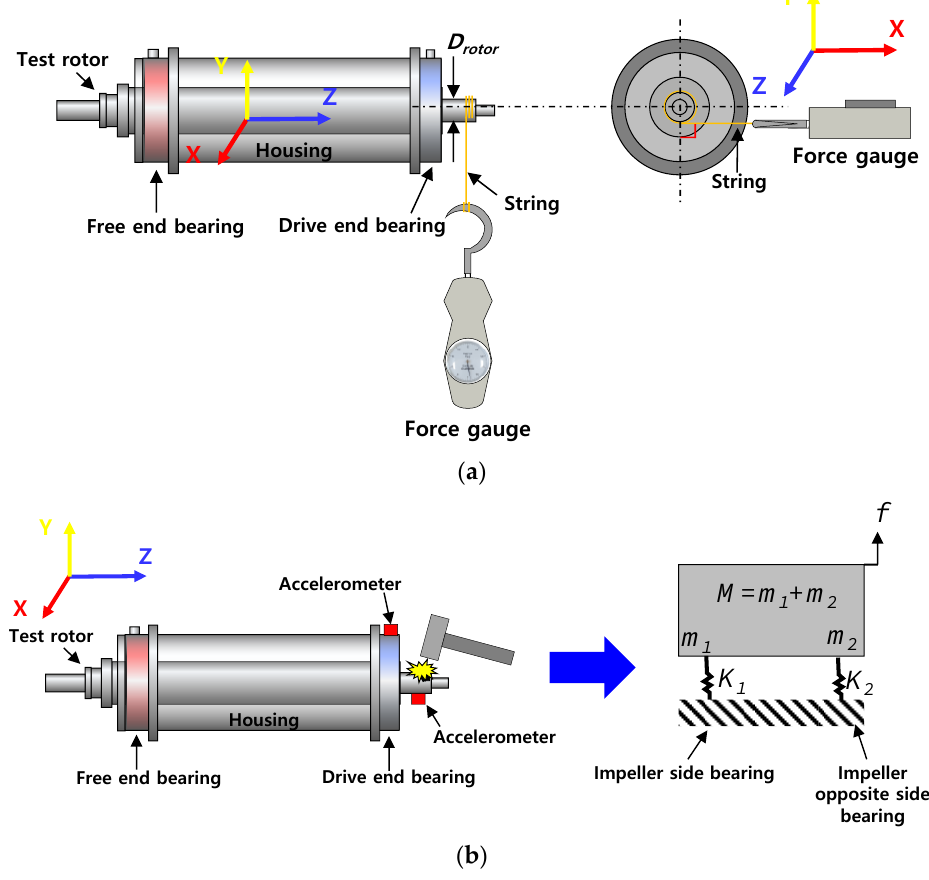
Figure 4. Schematic view (not to scale) of ( a ) torque measurement and ( b ) rap test for stiffness estimation.